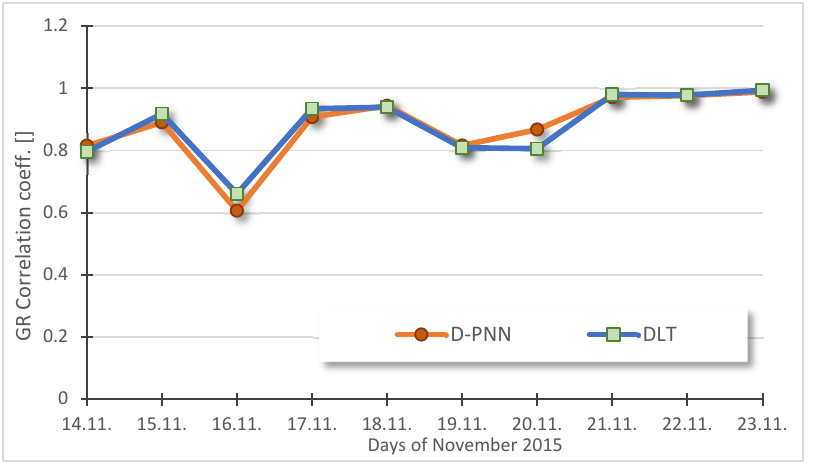
Figure 10. 10-day solar-radiation avg. prediction day Correlat. determin. coeff.: DNN = 0.878, DLT = 0.881 [].